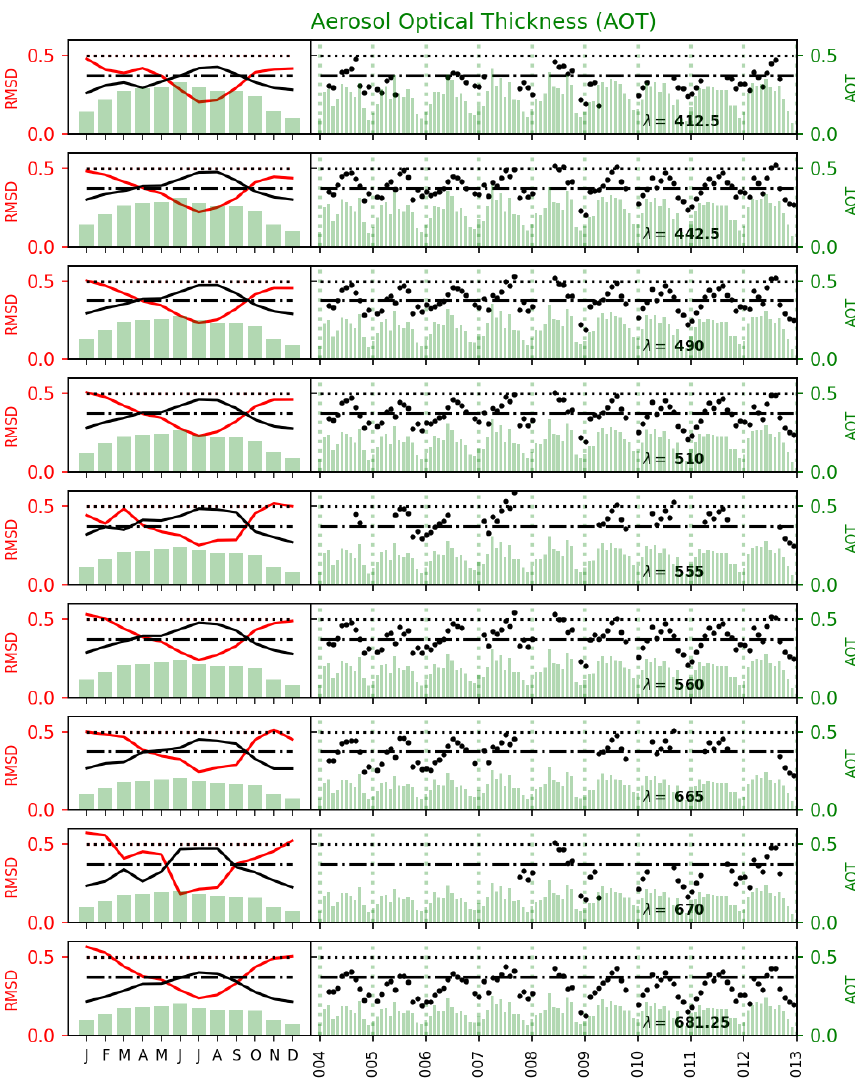
Figure 15. Comparison of the OASIM downward irradiance ( E d (λ 0 − ) at the nine wavelengths) to the BOUSSOLE data from 2004 to 2012 in terms of the RMSD and regression slope and their relationship with the MODIS aerosol optical thickness. The left section of each panel shows the monthly climatology of the RMSD (normalized by its averaged value, red lines and labels) and regression slope (normalized by its averaged value, black line), superimposed on the monthly climatology of the aerosol optical thickness (green bars and labels). Regression slope thresholds at 1 (dotted black line) and 0.75 (dot–dashed black line) are also shown. The right section of each panel shows the monthly means of the time series of the regression slope (black dots, with the 1 and 0.75 thresholds shown; dotted and dot–dashed black lines, respectively), superimposed on the monthly means of the time series of the aerosol optical thickness (green bars and